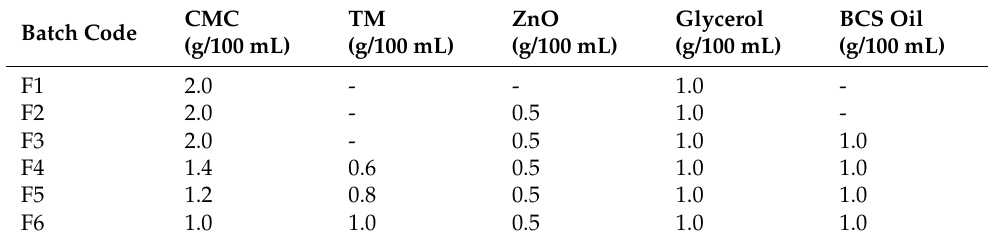
Table 1. Composition of the biocomposite film-forming solutions 1